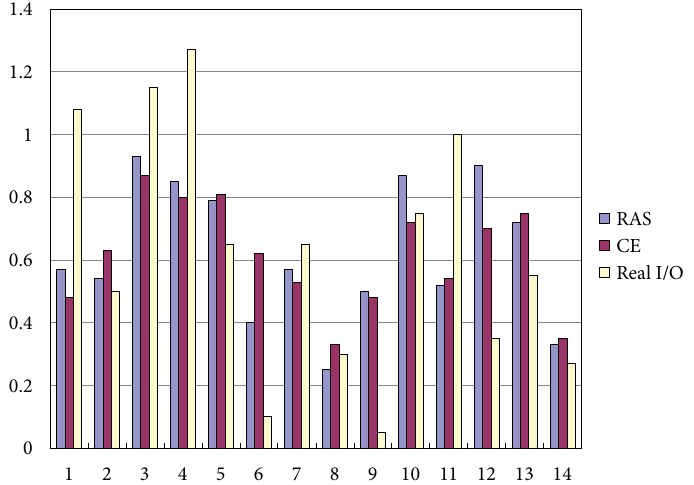
Fig. 2. Comparison of the actual and estimated sums of input coefficients of 14 Korean